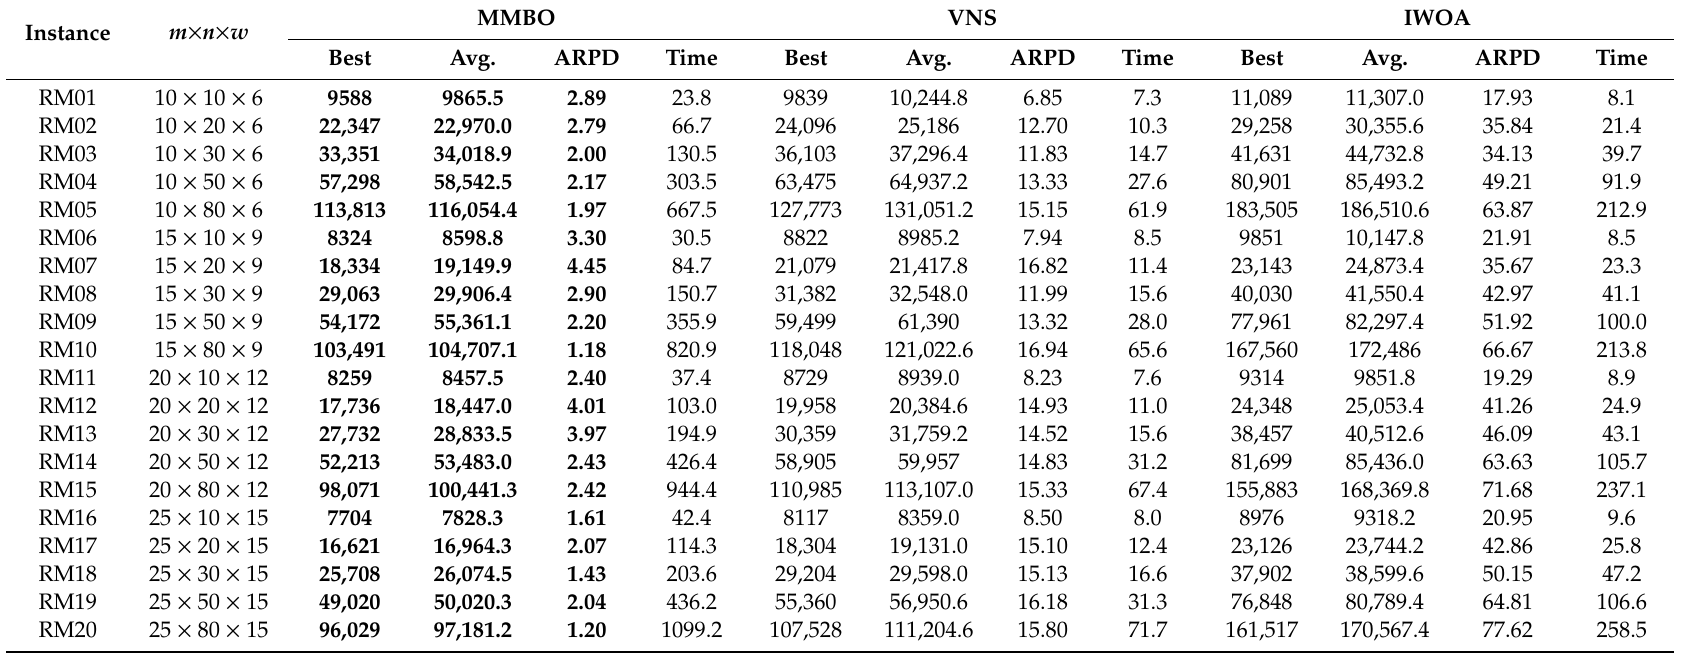
Table 4. Comparison results of di ff erent